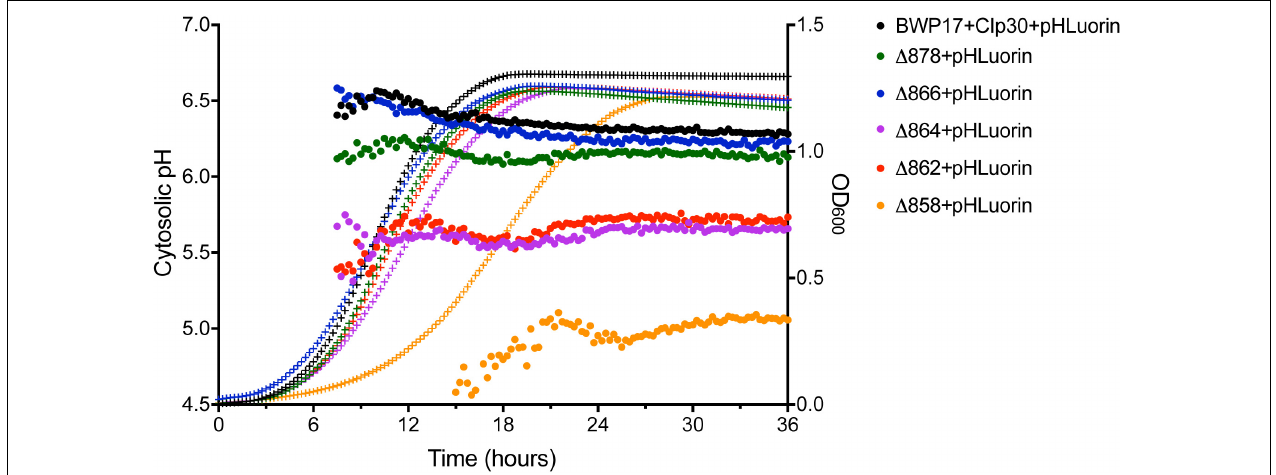
FIGURE 2 | Growth and cytosolic pH in Pma1p truncation mutants. Growth and cytosolic pH were measured concurrently in Pma1p truncation mutants by growing cells in YNB with 2% glucose in a plate reader with OD 600 readings and cytosolic pH readings taken at 15 min intervals. Cytosolic pH is plotted on the left y- axis and is represented by closed circles. OD 600 is plotted on the right y- axis and is represented by + symbols. Increased Pma1 truncation is correlated with decreased growth and increased cytosolic acidification. Graph represents the average of four individual experiments.